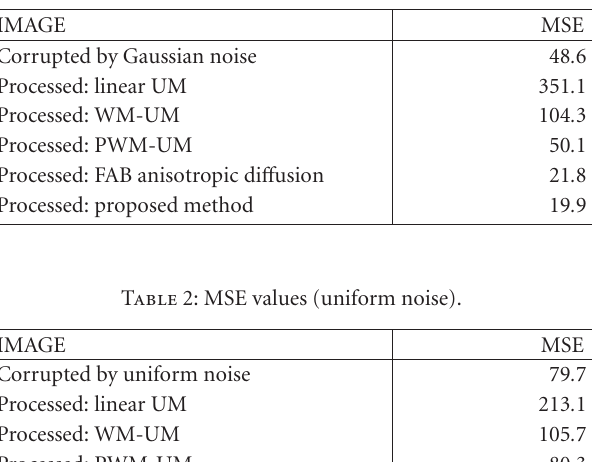
Table 1: MSE values (Gaussian noise).